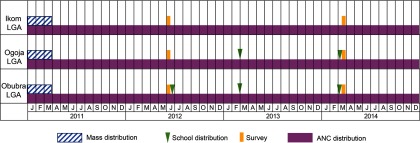
Modes and Timing of ITN Distribution and Baseline and Endline Surveys, Cross River State, Nigeria, 2011–2014Abbreviations: ANC, antenatal care; ITN, insecticide-treated net; LGA, local government area.